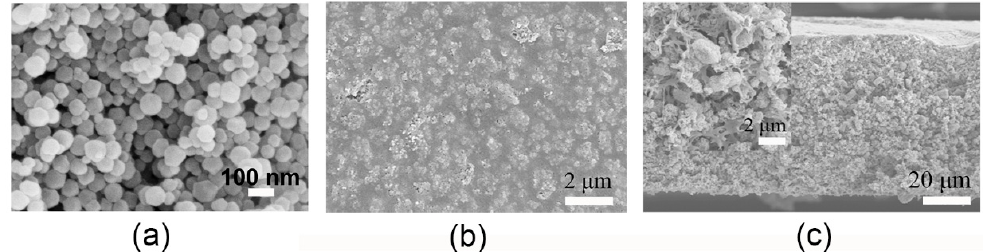
Figure 4. SEM images of ( a ) nanosized pure ZIF-8, ( b ) surface of ZIF-8 / PES, and ( c ) cross-section of ZIF-8 / PES. The inset picture shows an enlarged image. The solvent was DMF, and the loading of ZIF-8 was 60 wt . %.